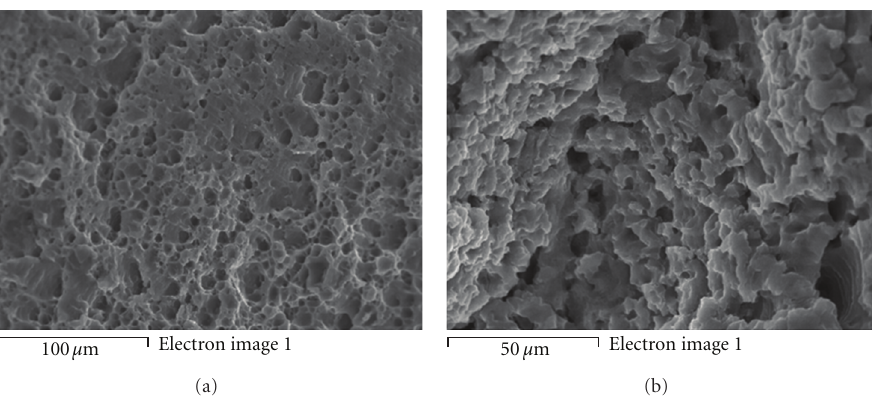
Figure 6: Fracture appearances for A5052-H3 at T = 353 K and σ = 230 MPa; X550, LT orientation (a), TL orientation (b) in 0.5M sodium chloride solution.